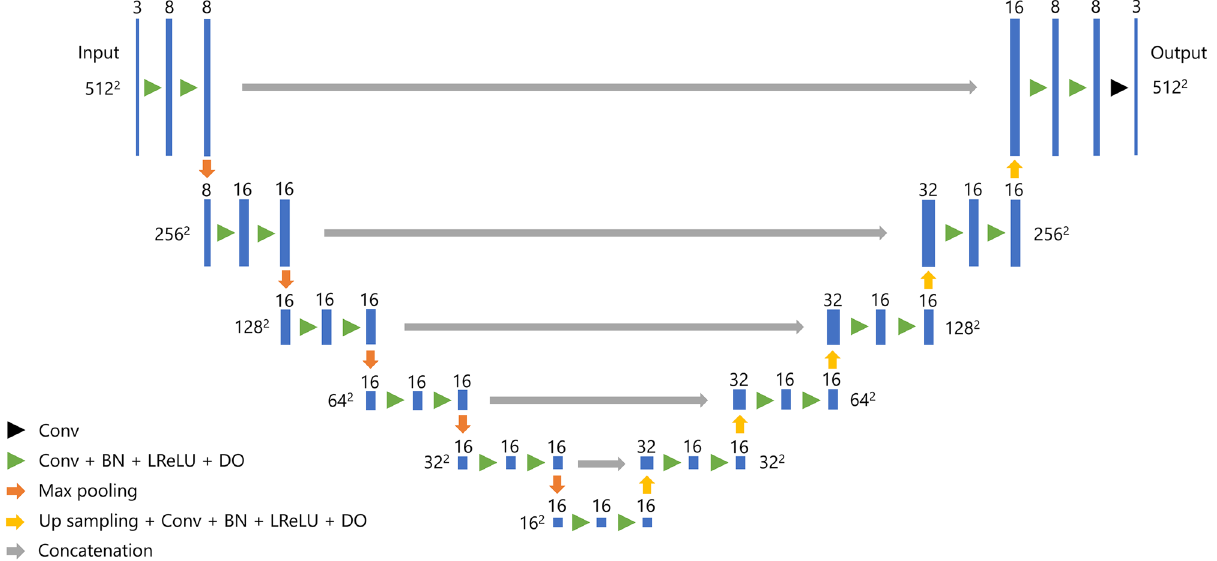
Figure 3. Our U-net architecture for segmentation of uterine endometrial cancer. Conv : convolution, BN : batch normalization, LReLU : Leaky Rectified Linear Unit, DO :